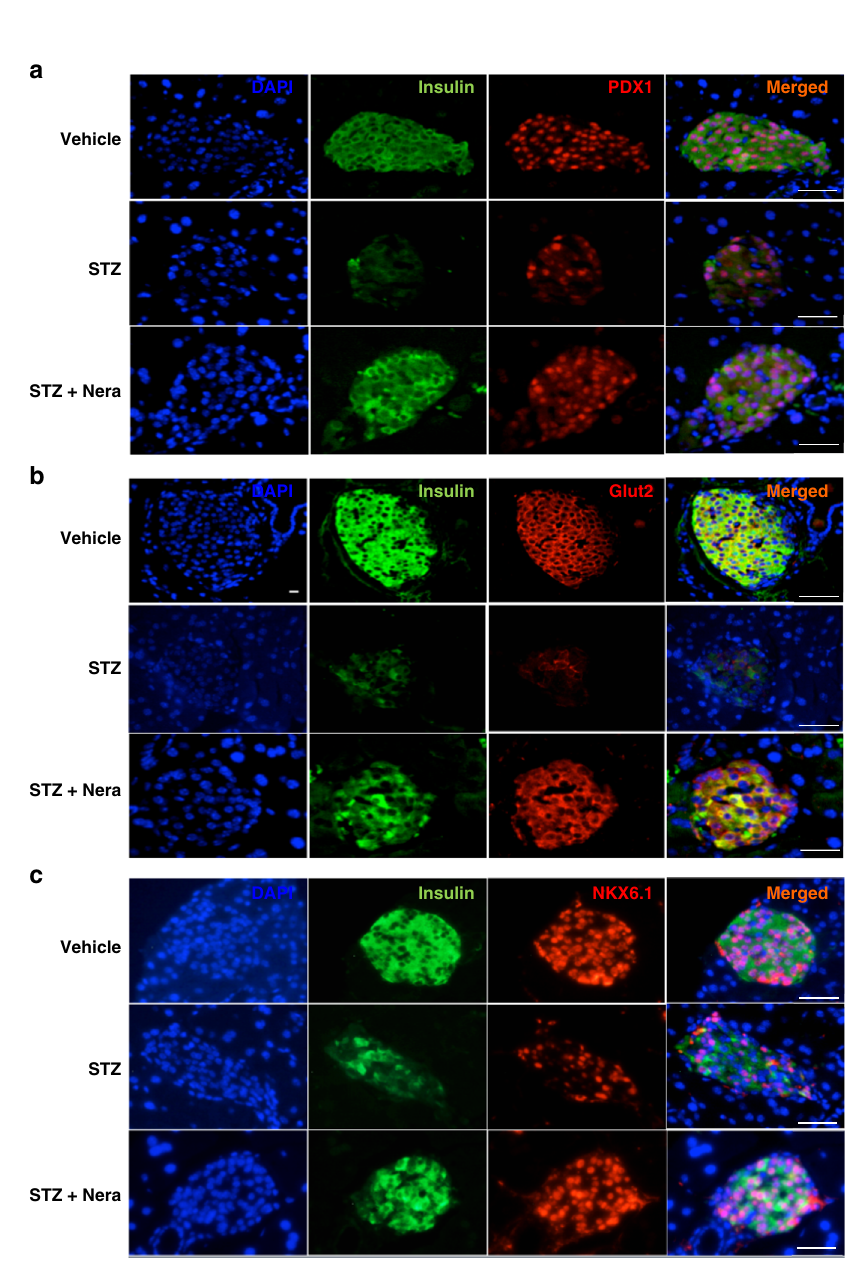
Fig. 7 Neratinib restores PDX1, NKX6.1, and Glut2 expression. Representative triple stainings for PDX1 (red, a ), Glut2 (red, b ), or NKX6.1 (red, c ), insulin (green), and DAPI (blue) are shown from vehicle-, STZ-, and STZ/Nera-treated mice ( n = 8, 4, 9 & 9 mice/group). Scale bar, 100 μ